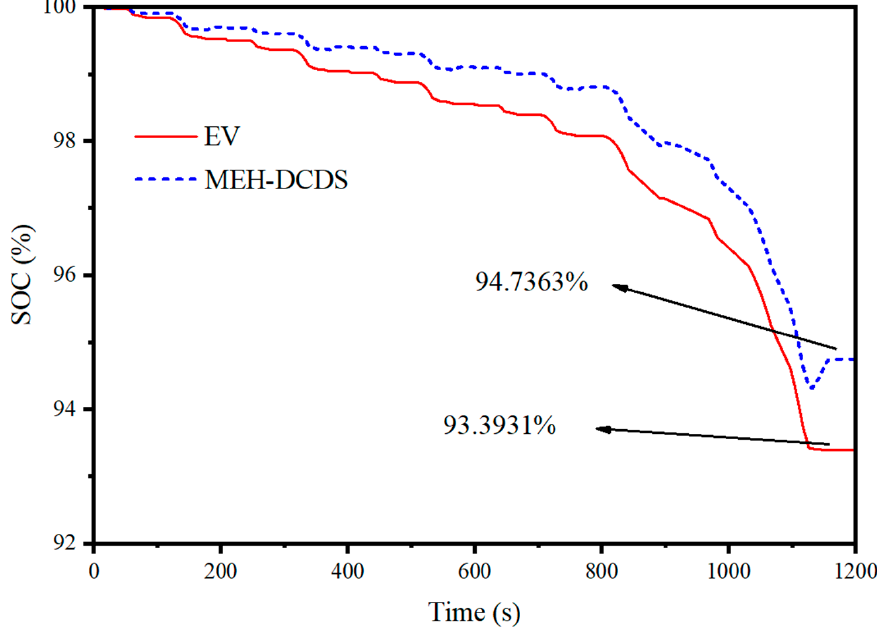
Figure 16. Diagram of the swashplate signal curve.